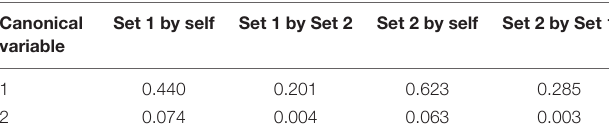
TABLE 2 | Proportion of variance explained two pairs of canonical correlation. Canonical